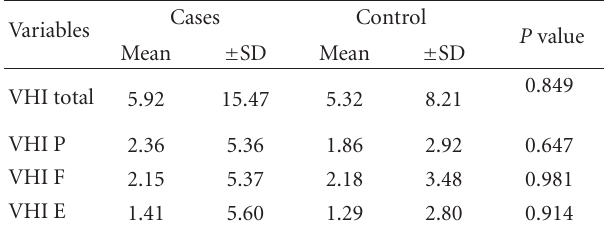
Table 1: Demographics. Table 2: Di ff erence between cases and control in terms of VHI